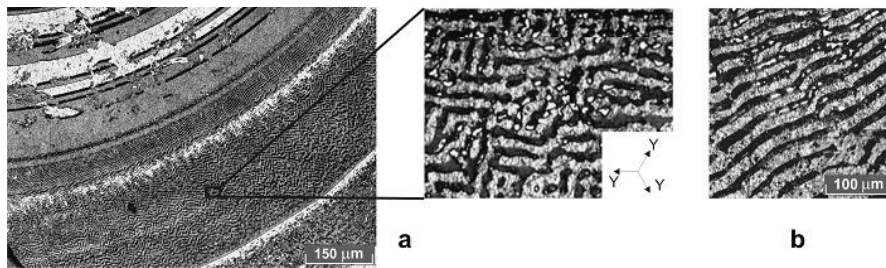
Figure 2. Self-similar domain microstructures of the fractal type: ( a ) in a LiNbO 3 :Tm (1.18 wt.%) crystal; ( b ) in an LiNbO 3 crystal irradiated with a dose of 106 Gy of γ -radiation. Images were captured with Thixomet Image Analyzer.